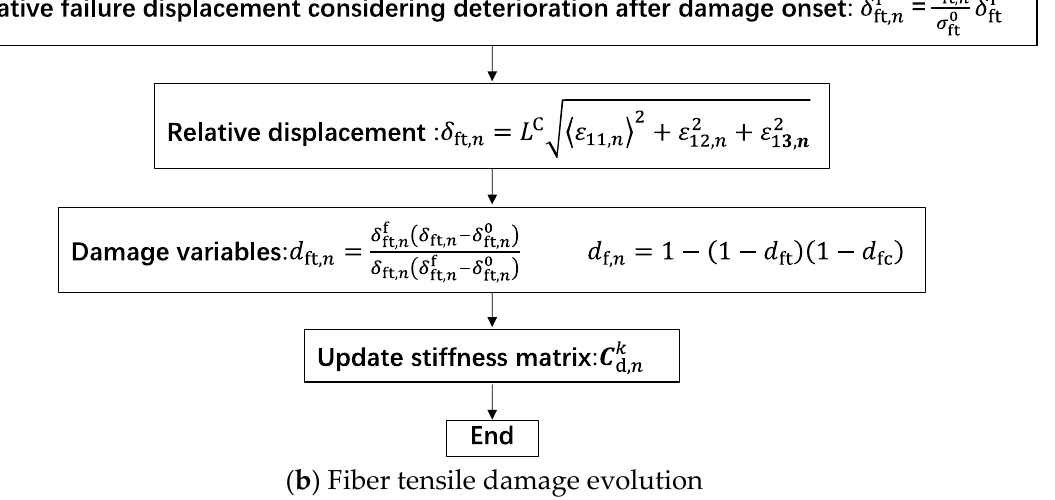
Figure 9. Flowchart for damage onset and evolution of fiber tensile failure mode.